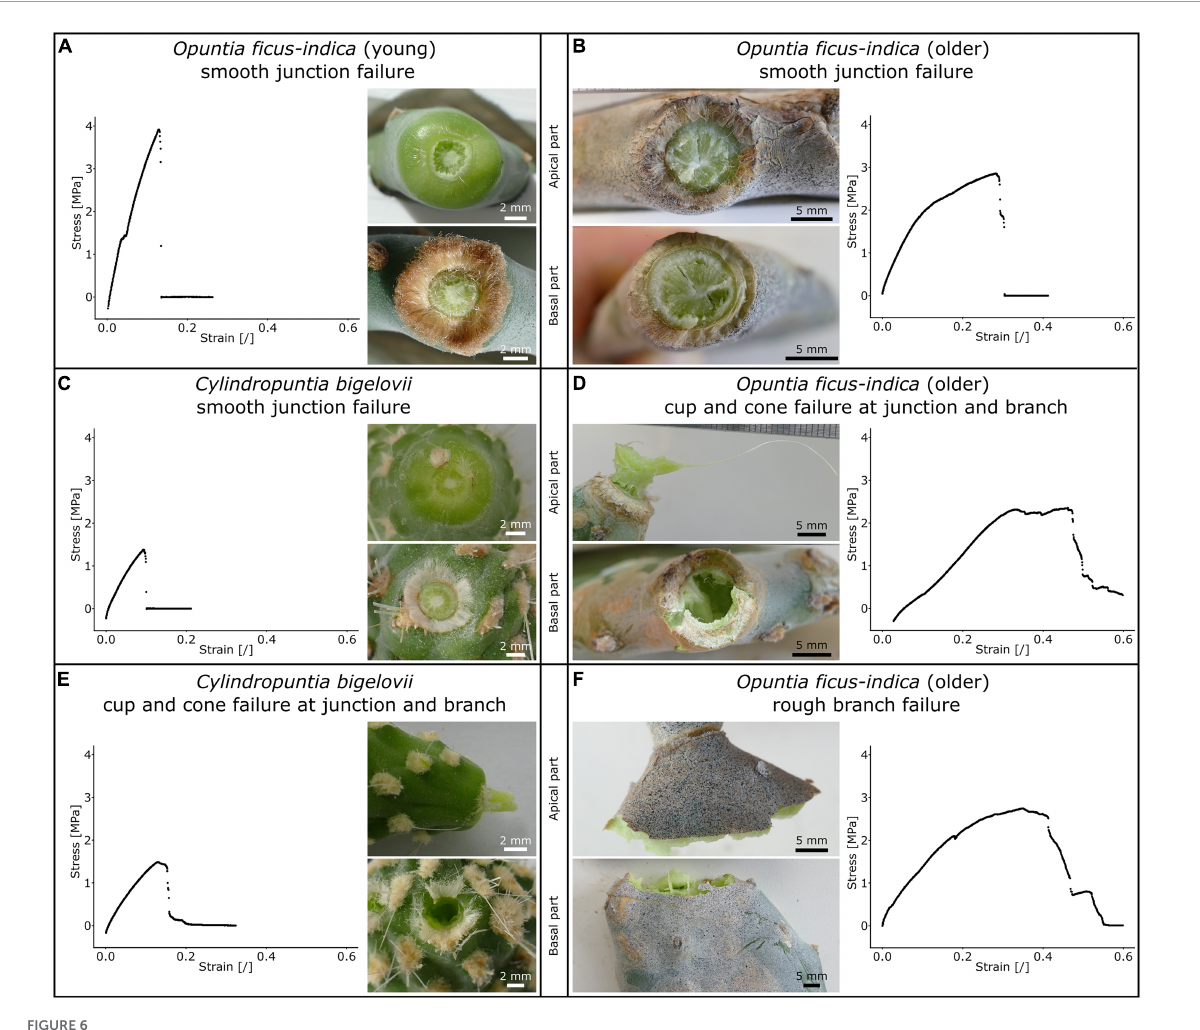
FIGURE6 Stress-strain curves of tensile tests until failure (for better comparability, the diagram axes have identical ranges) and images of the apical and basal fracture sites of the lateral junctions of Opuntia ficus-indica and Cylindropuntia bigelovii. Smooth junction failure of (A) , a young lateral O. ficus-indica junction with a large number of trichomes around the junction, (B) an older lateral O. ficus-indica junction with ruptures of the periderm coverage (brown tissue covering the epidermis), and (C) a junction of C. bigelovii . Cup and cone failure of (D) an older lateral O. ficus-indica junction (with strands of vascular bundles having been pulled out in the apical junction part and ruptures in the basal junction part) and of (E) a junction of C. bigelovii (consisting of the parenchyma and strands of vascular bundles) with failure at the junction and basal branch. (F) Rough branch failure of an older lateral O. ficus-indica junction with protruding strands of vascular bundles. The junction shows signs of elongation, but no pre-failure effects can be detected. We sprayed a stochastic pattern onto the surface of the samples shown in (B,F) to improve facet detection for digital image correlation analysis.